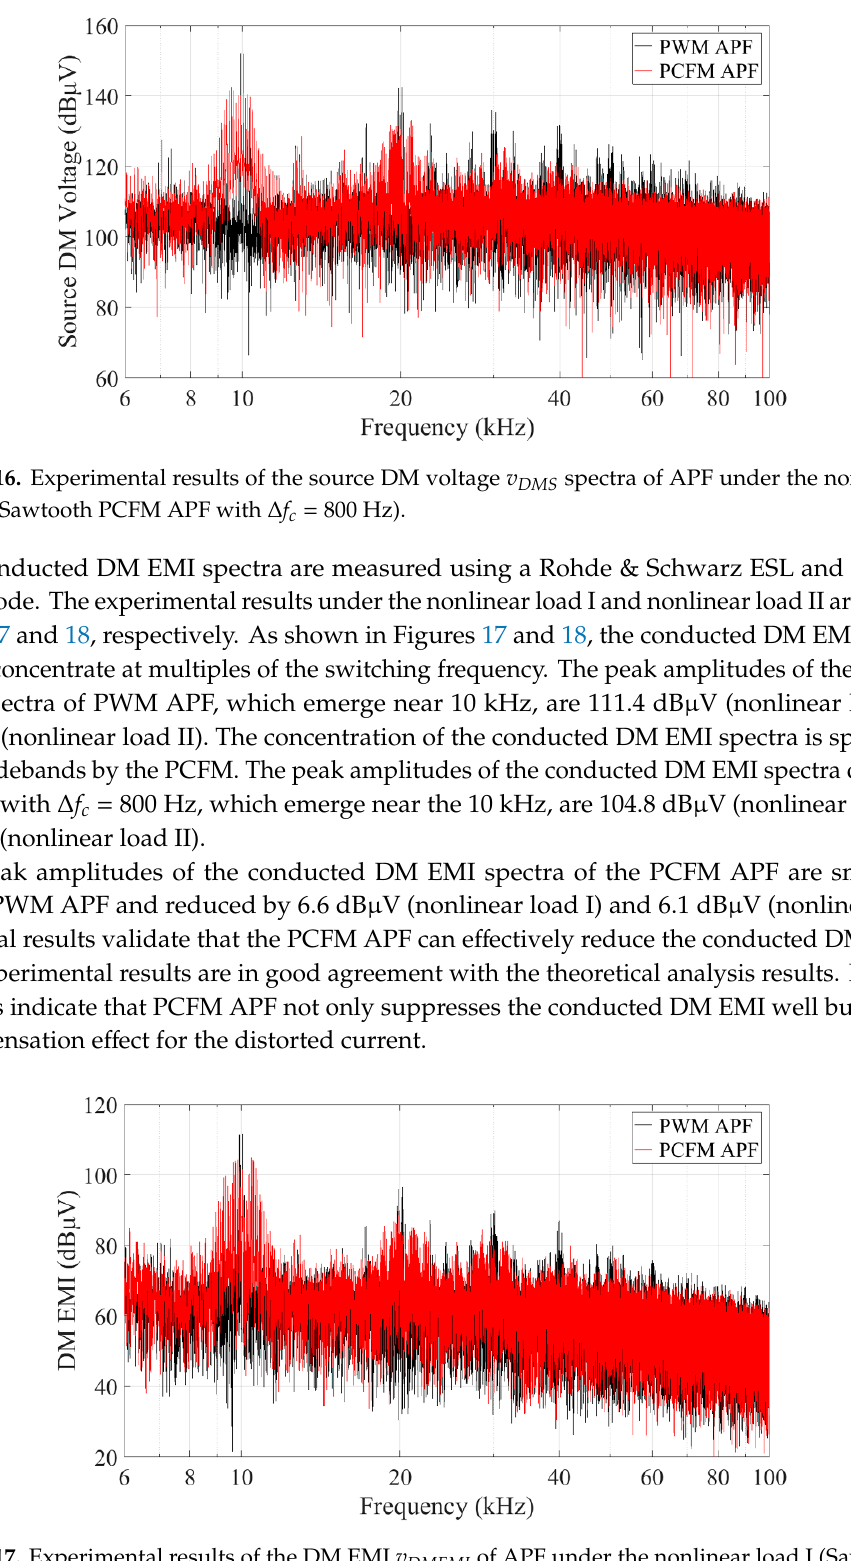
Figure 17. Experimental results of the DM EMI v DMEMI of APF under the nonlinear load I (Sawtooth PCFM APF with ∆ f c = 800 Hz).